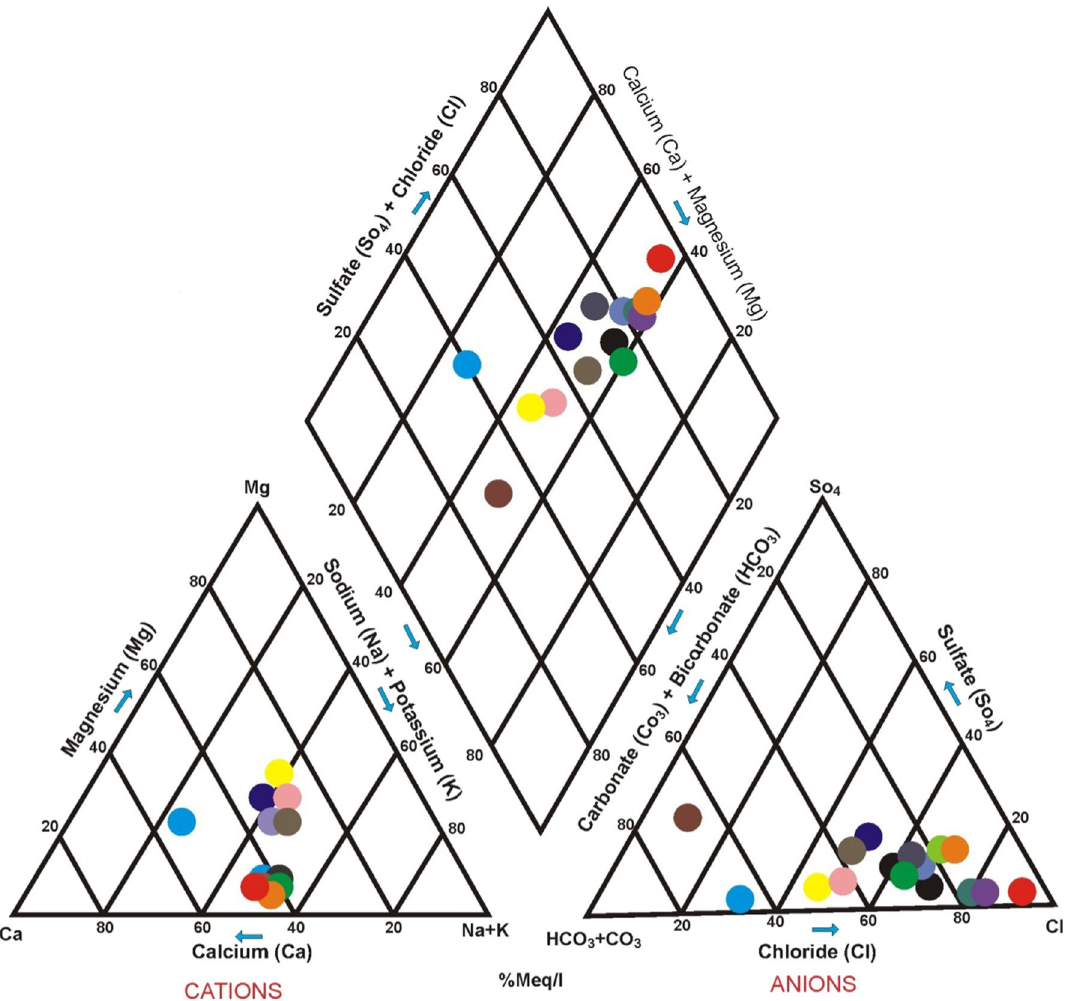
Fig. 3 Piper trilinear diagram for the groundwater samples of the study